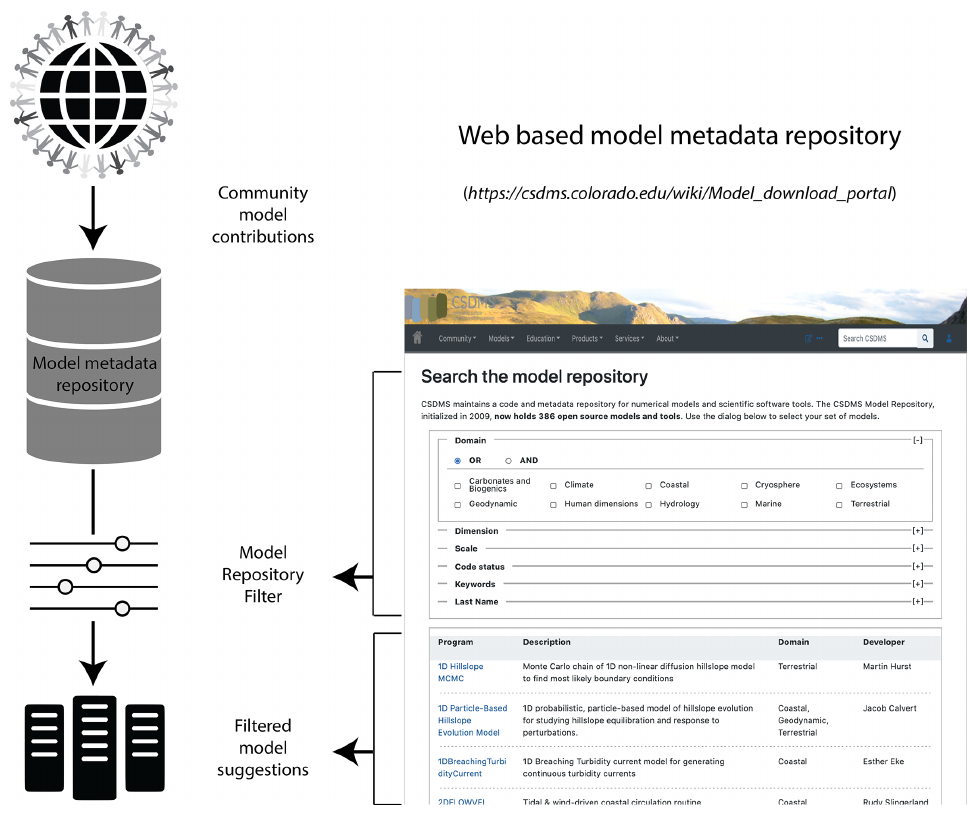
Figure 3. Schematic illustration of the CSDMS model repository. Community-contributed model codes are supplied with extensive metadata collected as part of the contribution process. These metadata allow repository users to filter their searches according to various criteria. An example of the filtered-search interface is shown at right.